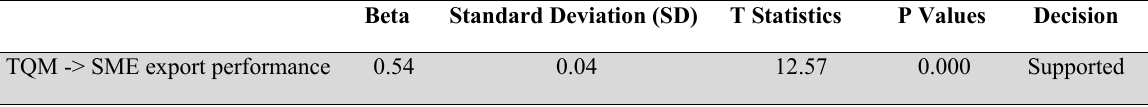
Fig. 6. PLS-SEM Bootstrapping (structural model) Beta and t-values Findings of structural model (path